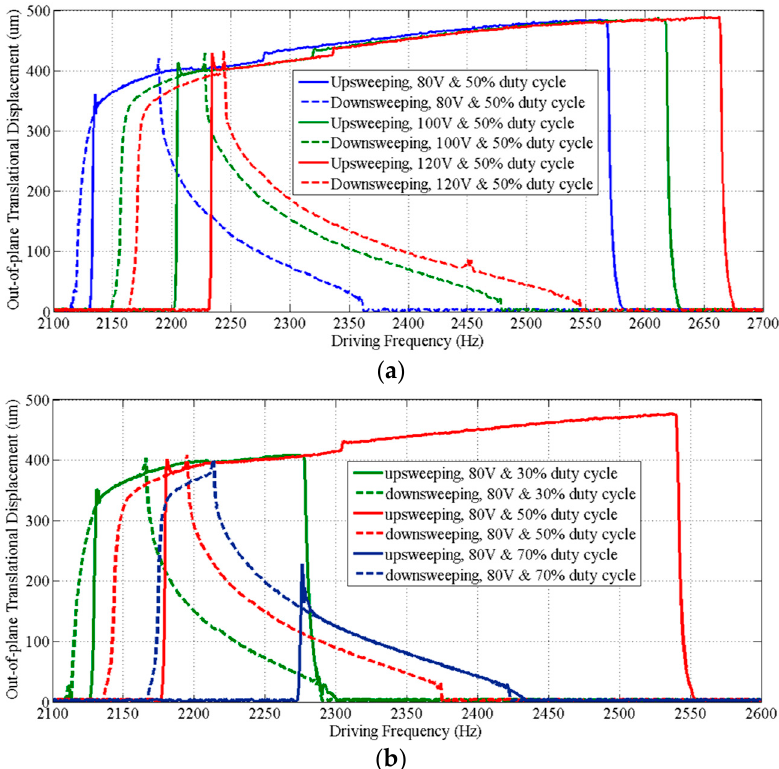
Figure 8. Frequency response curves of the out-of-plane translation motion. ( a ) Driven by square-wave signals with a 50% duty cycle at various voltages, the scanner exhibits a stiffness hardening behavior and a stiffness softening–hardening-mixed behavior during frequency upsweep and downsweep of the drive signals, respectively; ( b ) driven with square-wave signals that have different duty cycles at 80 V, the scanner exhibits not only stiffness hardening or softening–hardening-mixed behaviors, but also a stiffness softening behavior with upsweep of the frequency of a drive signal with a 75% duty cycle.